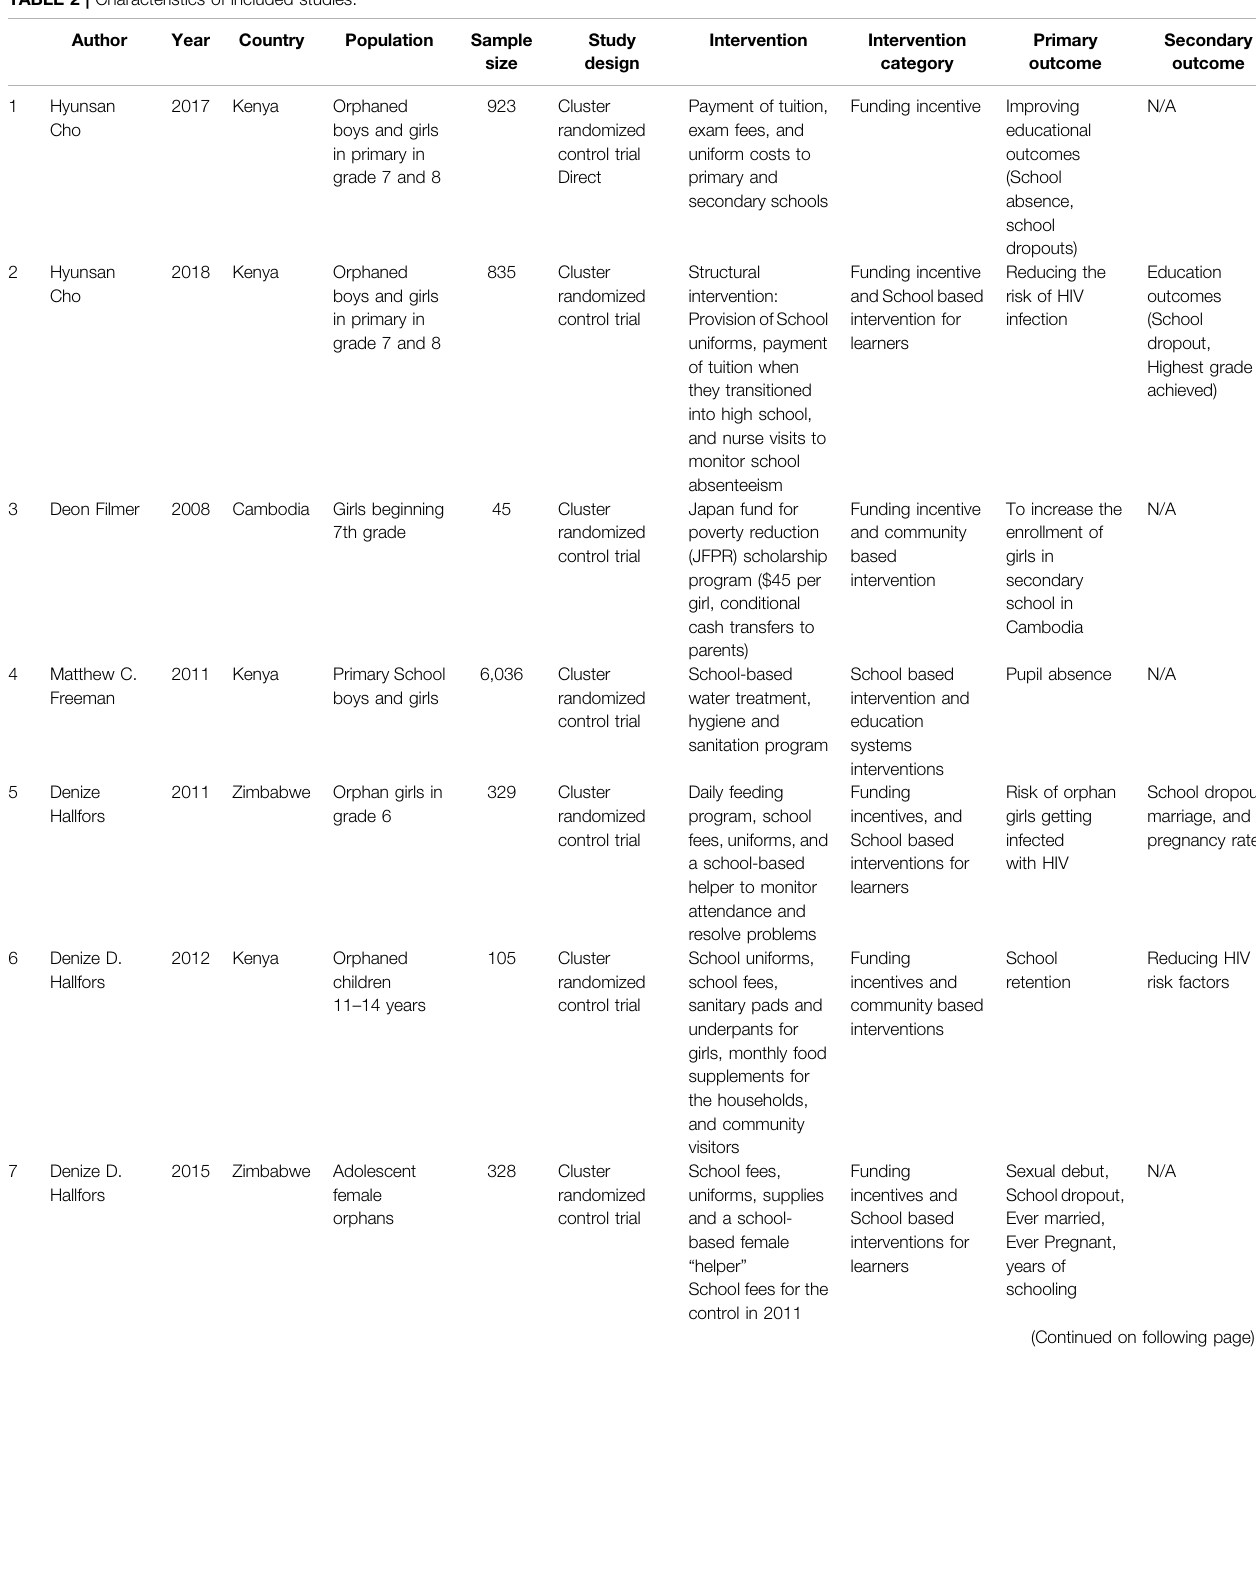
TABLE 2 | Characteristics of included